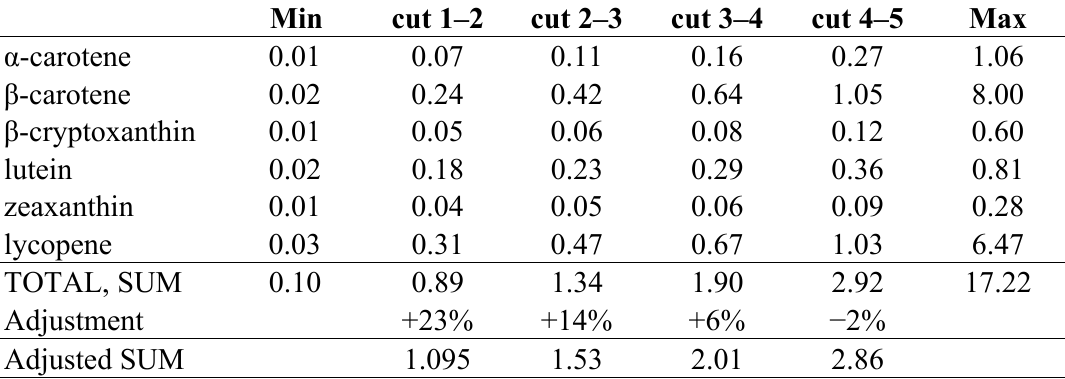
Table 2. Total Carotenoid Adjustment Applied to One Study, Dwyer 2004